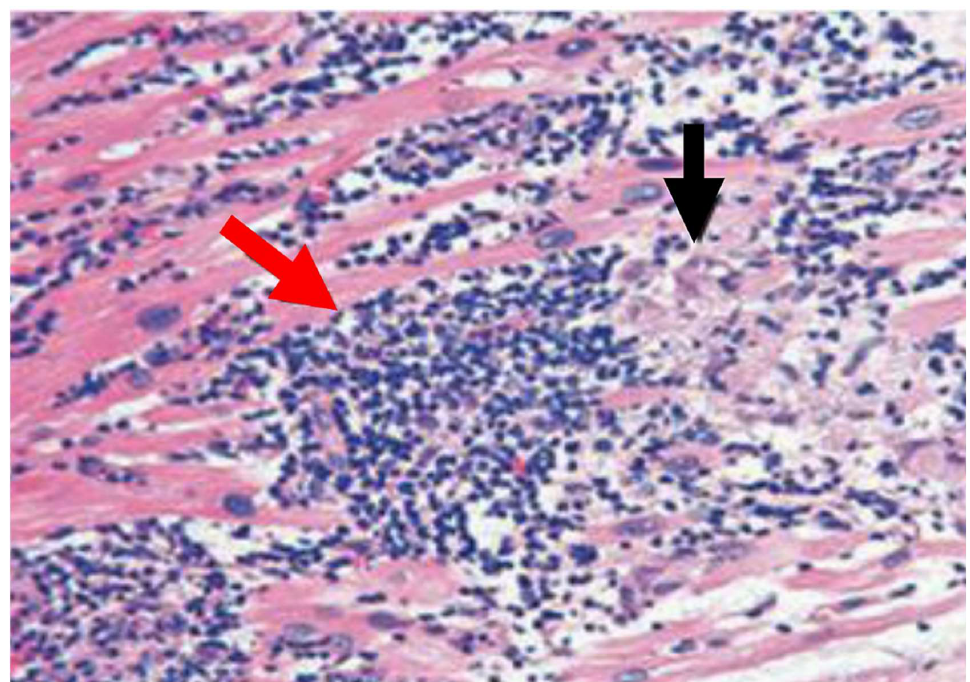
Figure 1. Image of patients with active myocarditis that is suggestive of a lymphocytic and histiocytic infiltrate and higher T lymphocytes in heart-tissue sections. Hematoxylin and eosin immunohistochemistry of heart tissue samples depicts characteristic lesions of acute myocarditis with widespread lymphocytic and histiocytic infiltrate (red arrow) and associated myocyte damage (black arrow).